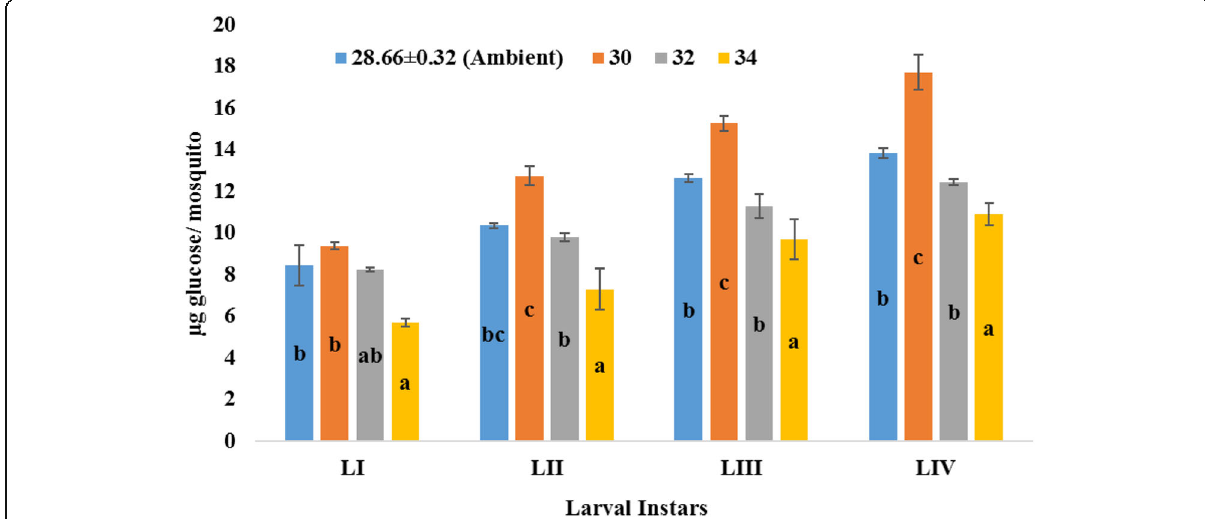
Fig. 5 Effects of rearing-water temperature on teneral glucose accumulation across larval instars (LI – IV) of Culex quinquefasciatus mosquito. Temperature bars with same letter at each larval instar are not significantly different at p <0.05 according to analysis of variance. Values are expressed as mean±SD